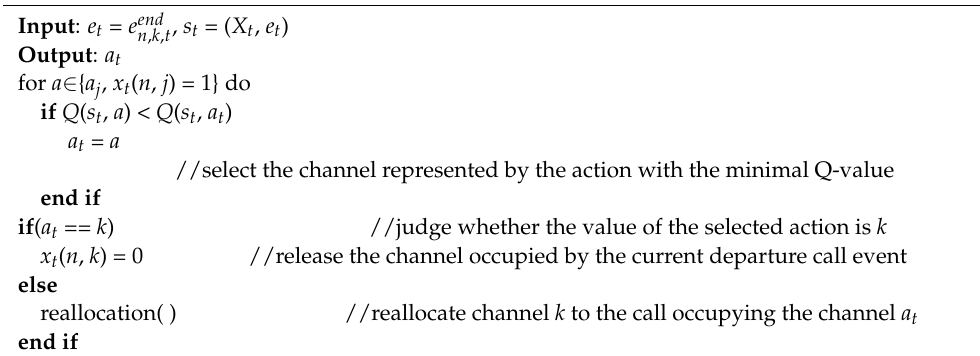
Algorithm 3: Policy for a departure call